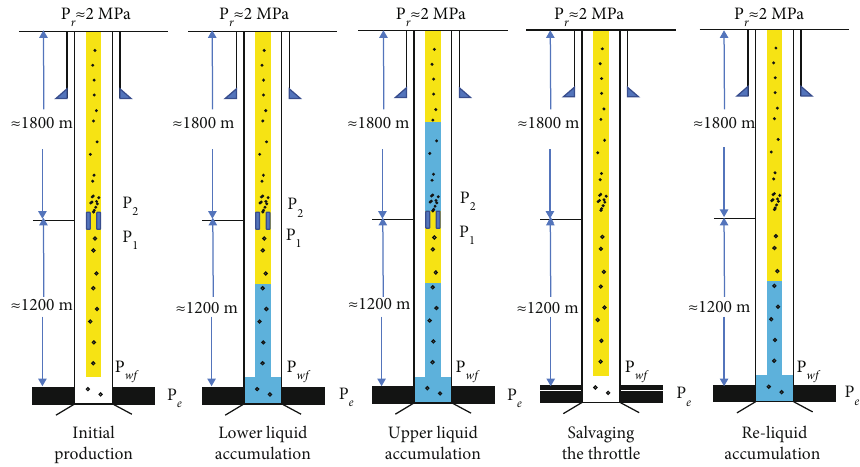
Figure 2: Production stage division of downhole throttling gas